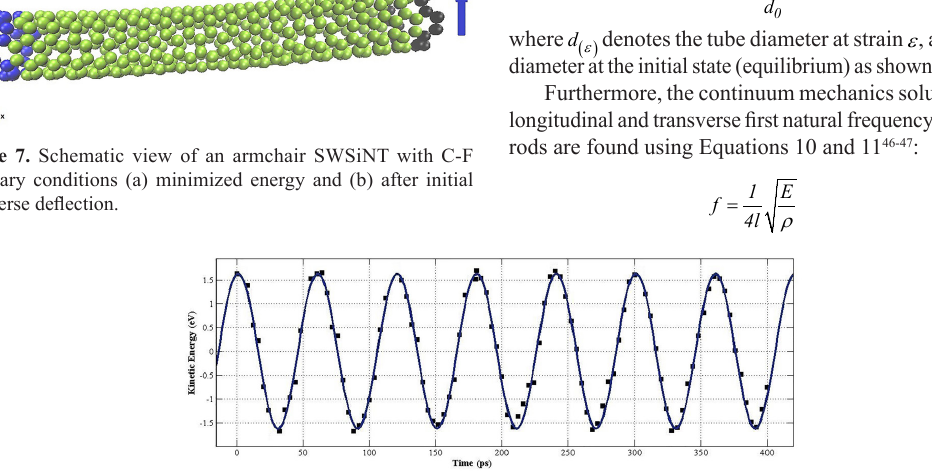
Figure 8. Curve fitting to the profile of system kinetic energy for a period of 400 ps during torsional free